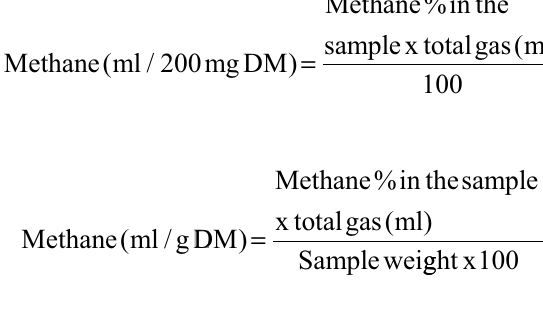
Table-3: Chemical composition (g/100g DM) of roughage, concentrate, and basal diets. Item